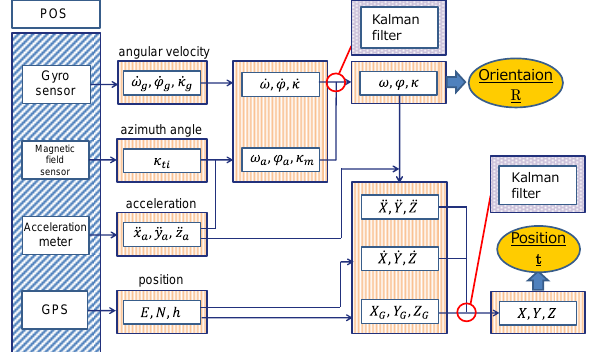
Figure 1. Flow of the POS data